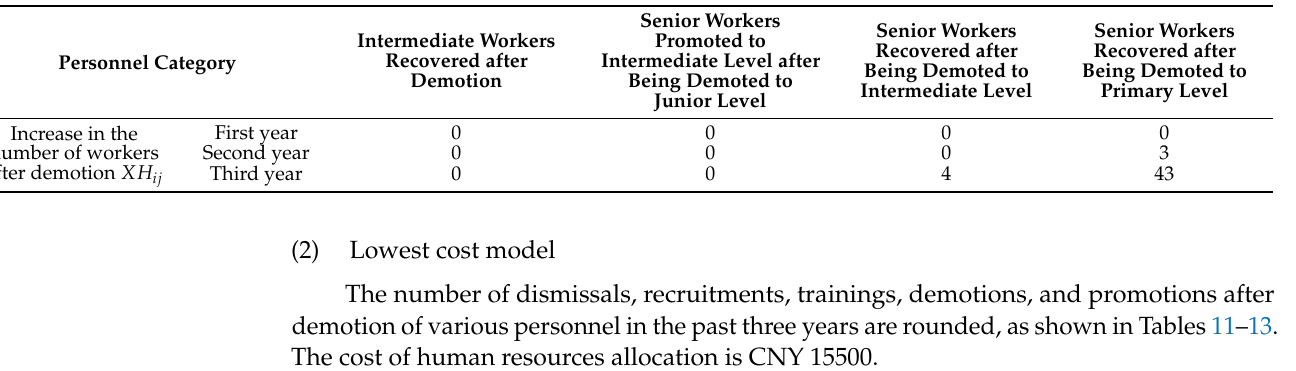
The number of dismissals, recruitments, trainings, demotions, and promotions after demotion of various personnel in the past three years are rounded, as shown in Tables 11–13. The cost of human resources allocation is CNY